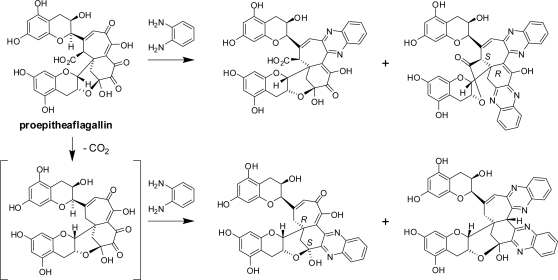
Quinoxaline derivatives of proepitheaflagallin [38].